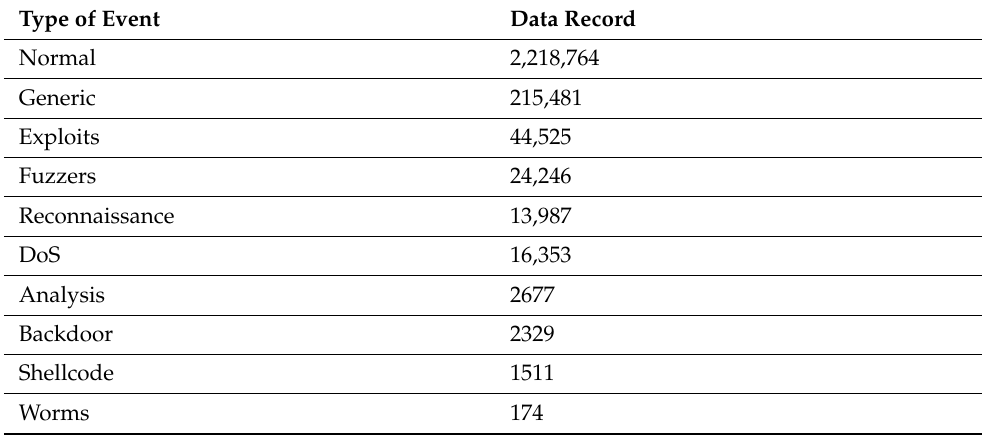
Table 5. The total numbers of records in the UNSW-NB15